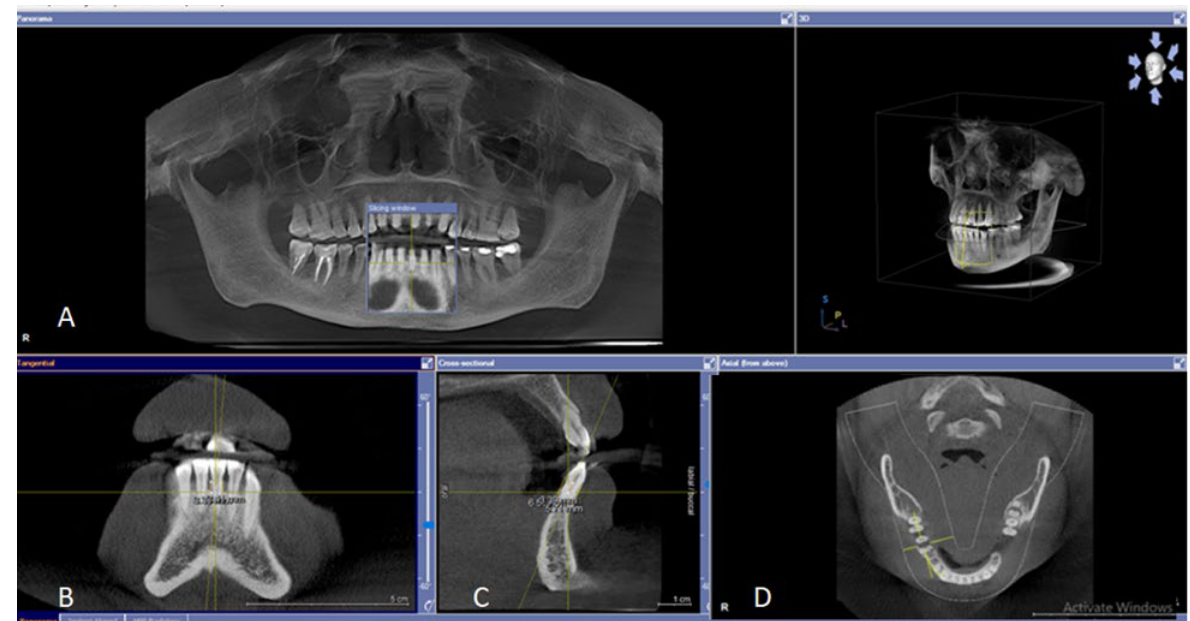
Figure 1. Scanning dentogingival region by CBCT to detect the osseous lesions and measure the amount and pattern of osseous defect. ( A ) An overview of the region by Orthopantomography (OPG) to determine the level of alveolar crest, in particular at the proximal and furcation region. ( B ) Tangential view for inspecting and measuring interproximal osseous defects. ( C ) Cross-sectional view for the detection of osseous defects in buccal and lingual aspects. ( D ) Axial view for the detection of osseous defects at furcation areas.